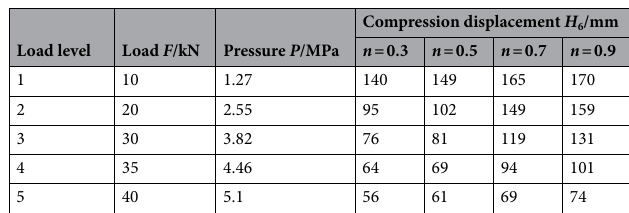
Table 4. Initial indenter height at the different load